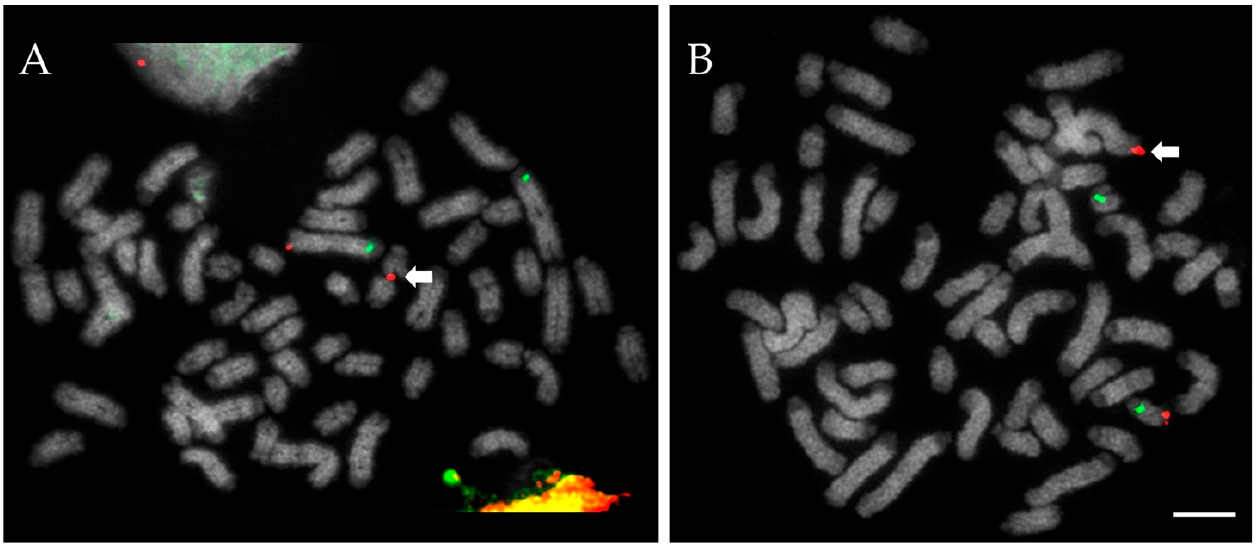
Figure 1. ( A ) Probes for proximal 1q (green) and distal 1q (red) both correctly hybridize to the normal chromosome 1; however, a translocation is detected due to the distal q-arm signal localizing on chromosome 25 instead (arrow). ( B ) Probes for proximal 25q (green) and distal 25q (red) both correctly hybridize to the normal chromosome 25; however, a translocation is detected due to the distal q-arm signal localizing on chromosome 1 instead (arrow). Together, the two images ( A , B ) establish this was a case of reciprocal translocation (RECT) t (1:25). DNA counterstained in DAPI (grey). Scale bar = 5 µm.